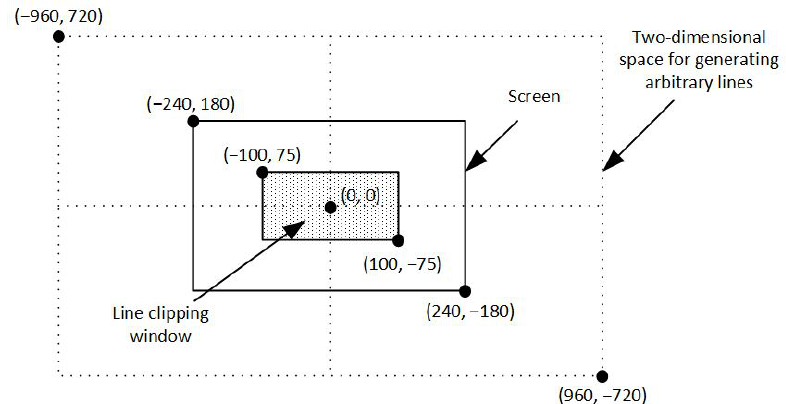
Figure 25. Defining the clipping window as well as the two-dimensional space for generating arbitrary lines.